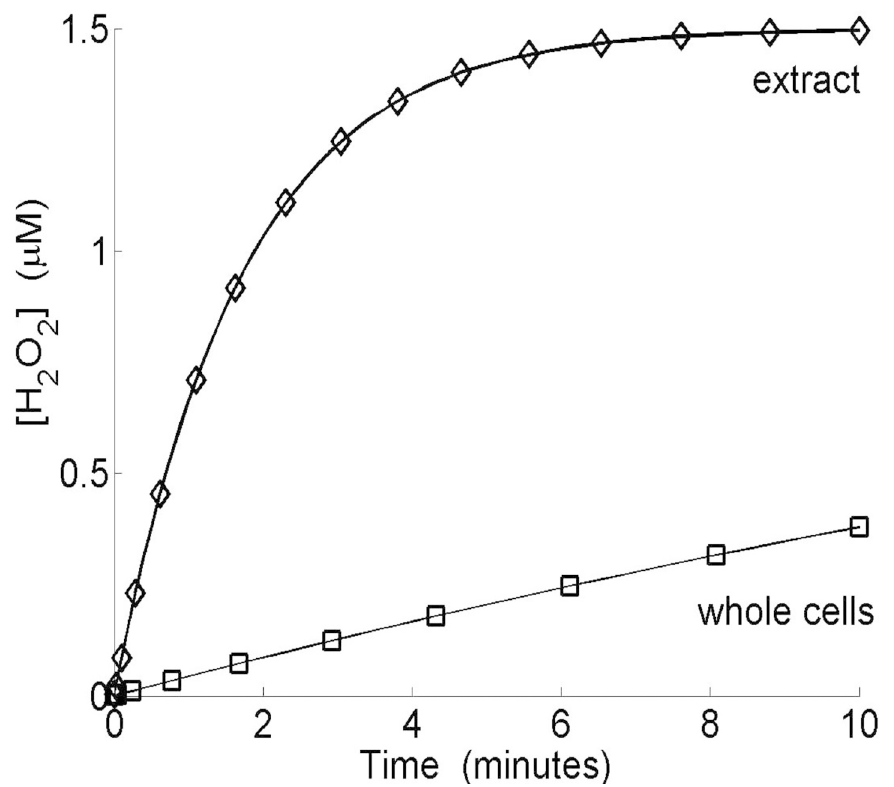
Fig 6. In silico , breakdown of exogenous H 2 O 2 by whole cells (Ahp(-) mutant) or cell extract. Simulation runs with 4 × 10 6 cells ml − 1 . Moreover, Seaver and Imlay ([5]) observed that an Ahp(-) mutant contained seven times as much total Cat as wild-type cells. We therefore used the same